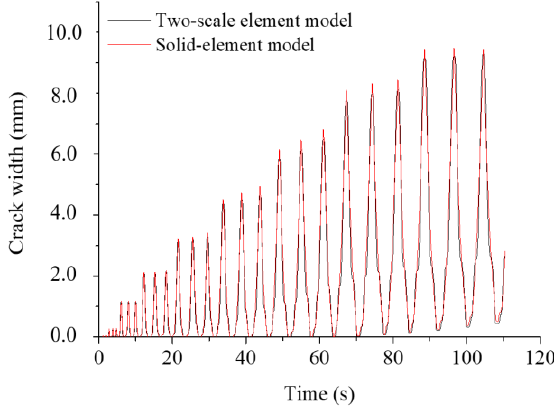
Figure 12. Time–history curves of crack width.